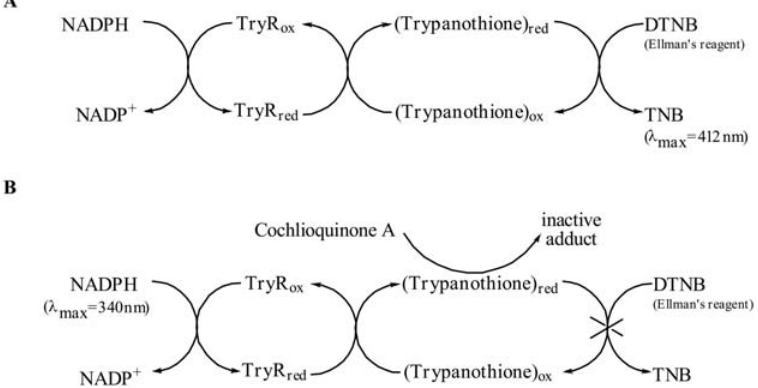
Figure 6. (A) Schematic view of the chemical and enzymatic reactions involved in the TryR assay resulting in the reduction of the Elmman’s reagent (DTNB) to the yellow-colored 2-nitro-5-thiobenzoic acid (TNB); (B) Same as above, showing the interference of cochlioquinone A resulting in a false positive readout due to its reaction with the reduced form of trypanothione, interrupting the chemical reduction of